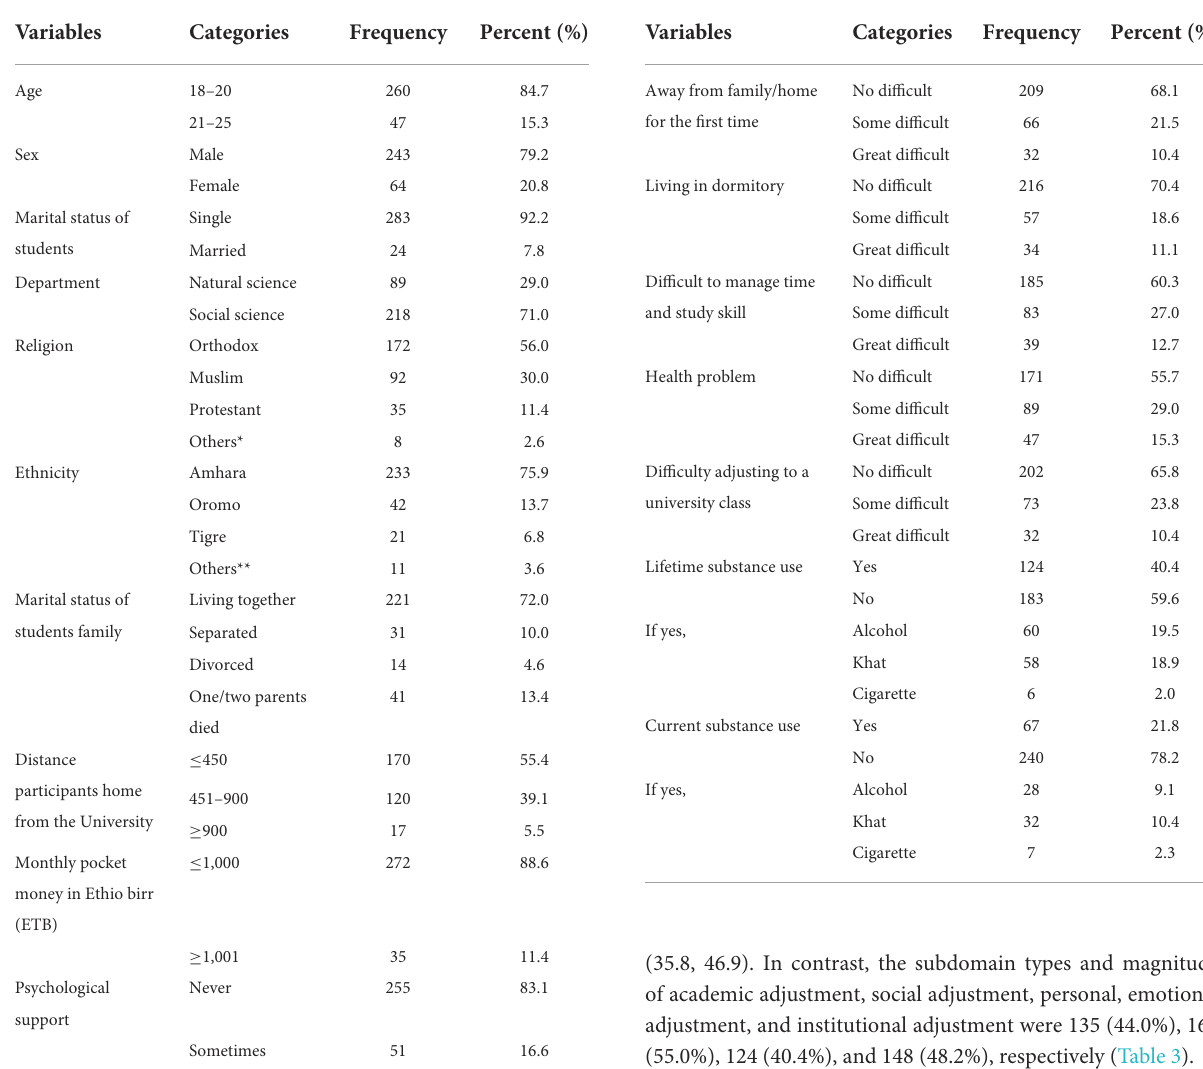
TABLE 1 Sociodemographic characteristics of Wollo University main campus regular first-year undergraduates, Northeast Ethiopia, Dessie, 2020 ( n = 307).